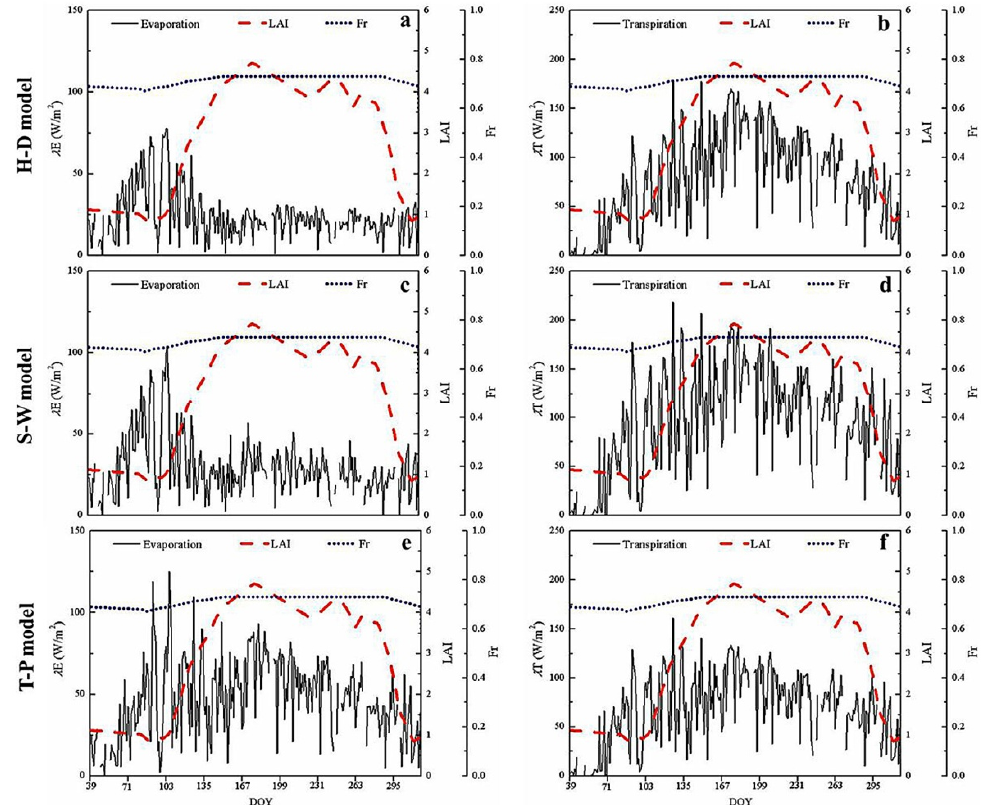
Figure 5. Variations in daily leaf area index (LAI), fractional vegetation coverage ( F r), and estimated evaporation ( λ E) ( left ) and transpiration ( λ T) ( right ) from three dual-source ET